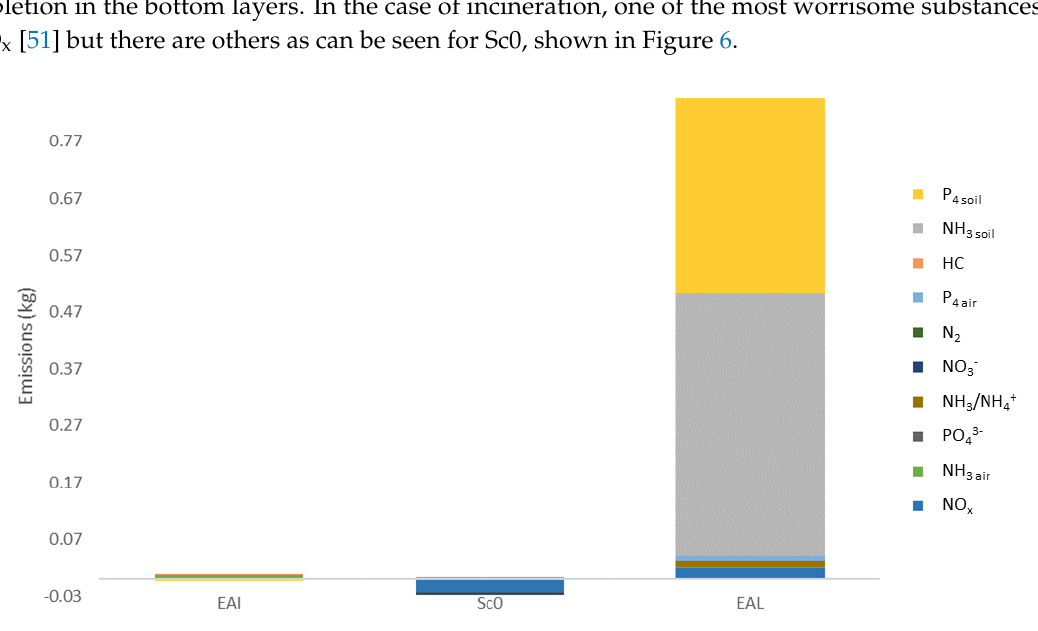
Figure 6. Eutrophication potential comparison for the reference case (Sc0) among average European scenarios. Results refer to one tonne of treated residues.